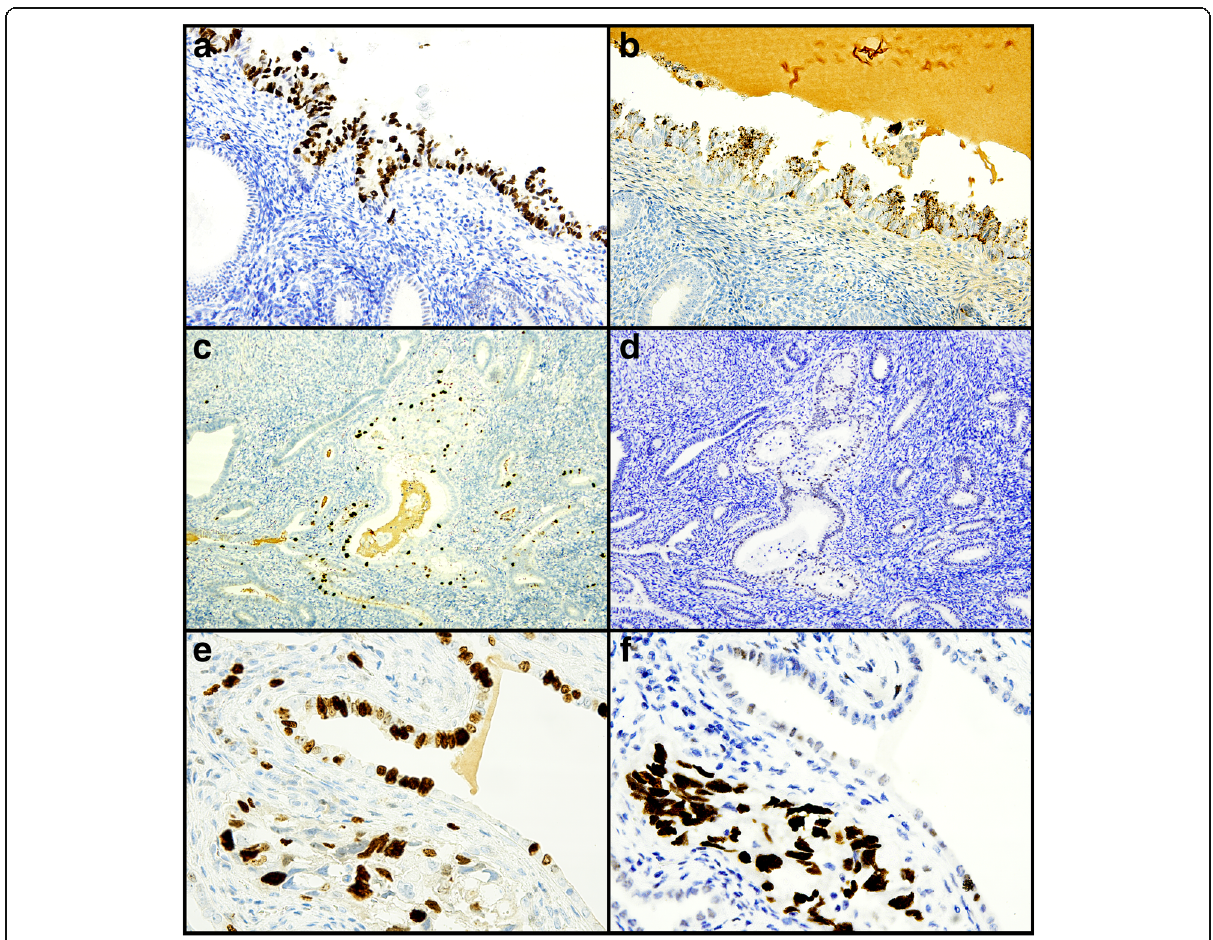
Fig. 4 Case 2. P53 overexpression ( a ) and Napsin A positivity ( b ) in CC-EIC (magnification 200X). Increased Ki67 expression ( c ) and p53 wild-type expression ( d ) in AEH/EIN-like putative precursor (magnification 100X). High Ki67 expression ( e ) and p53 wild-type expression ( f ) in metaplastic- like putative precursor (top right) in comparison to invasive clear cell carcinoma (bottom left) (magnification